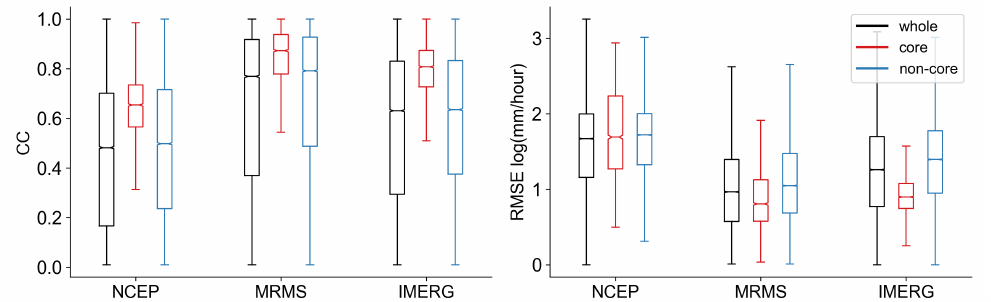
Figure 6. Boxplot of MTC measured CCs and RMSEs for three products grouped by whole, core, and non-core regions in Hurricane Harvey. Extreme values, i.e., outliers (outside of 1st/3rd quartile ∓ inter-quartile), are ignored to visualize the difference. The notch represents the median value for the samples in the